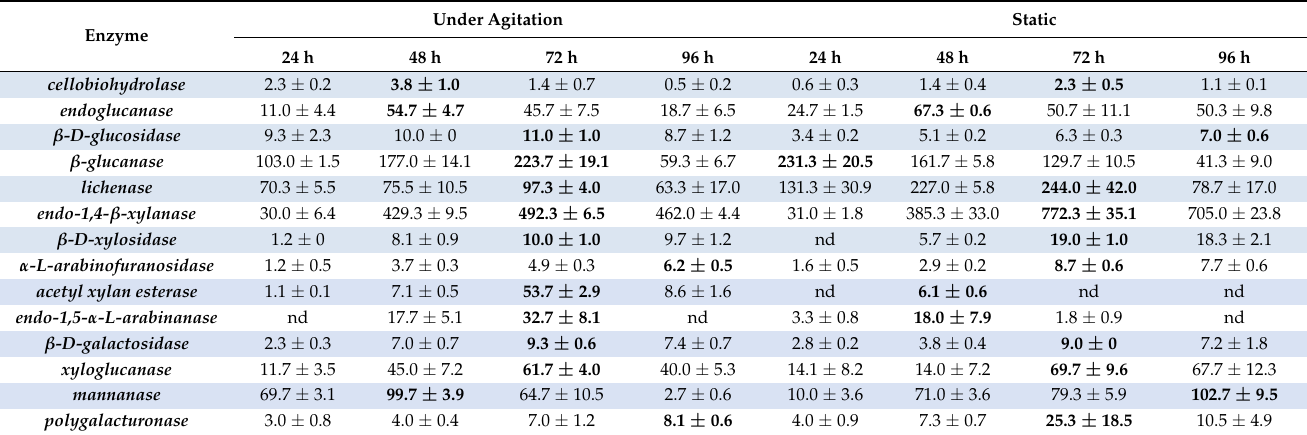
Table 3. Enzymatic activities of Trichoderma longibrachiatum LMBC 172 cultivated with jatoba seeds during different times. Under Agitation Enzyme